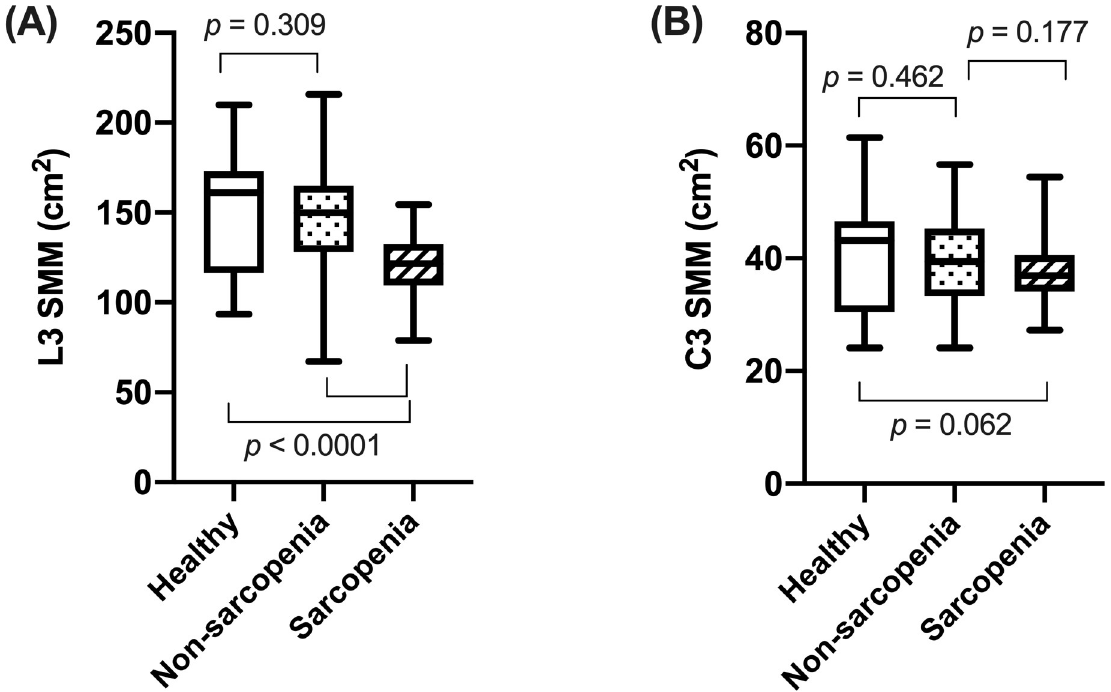
Fig 2. Comparison of skeletal muscle mass among the three groups. SMM, skeletal muscle mass.